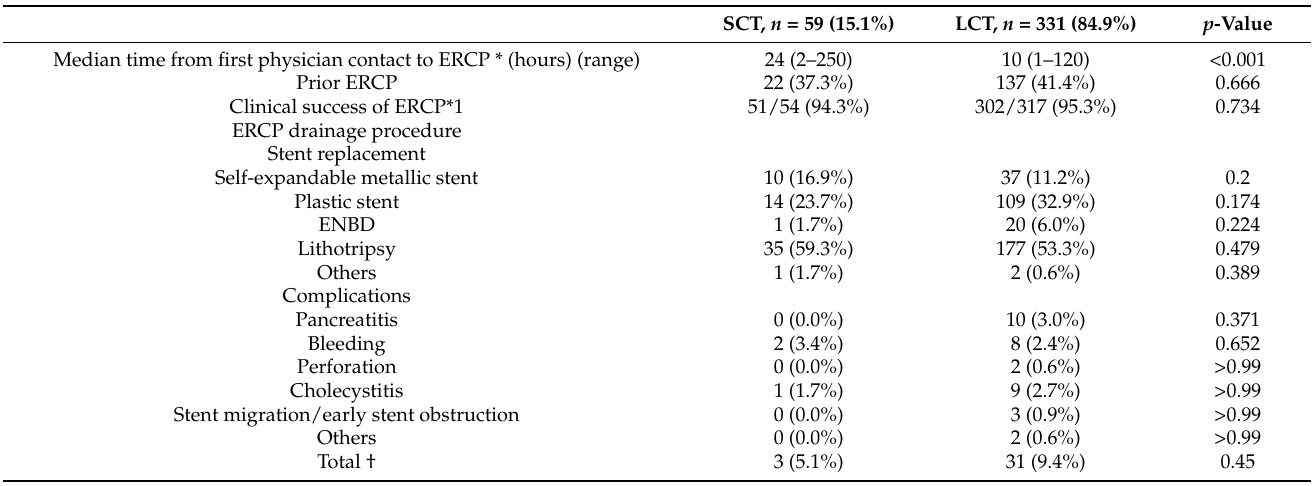
Table 2. ERCP findings.